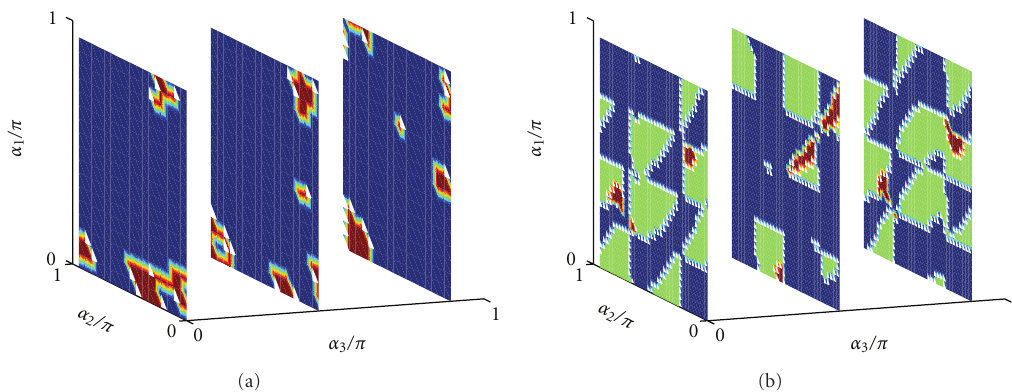
Figure 3: (a) Experimental operating regimes (red) of the laser shown in Figure 1. (b) Predicted operating regimes (red) of the CQGLE (8). The green region satisfies condition (20) but no stable pulses are found. Here B = 1 / 3, K = 0 . 1, g 0 = δ , D = − 0 . 3, τ = 0 . 2, and α p = 0 . 45 π (from